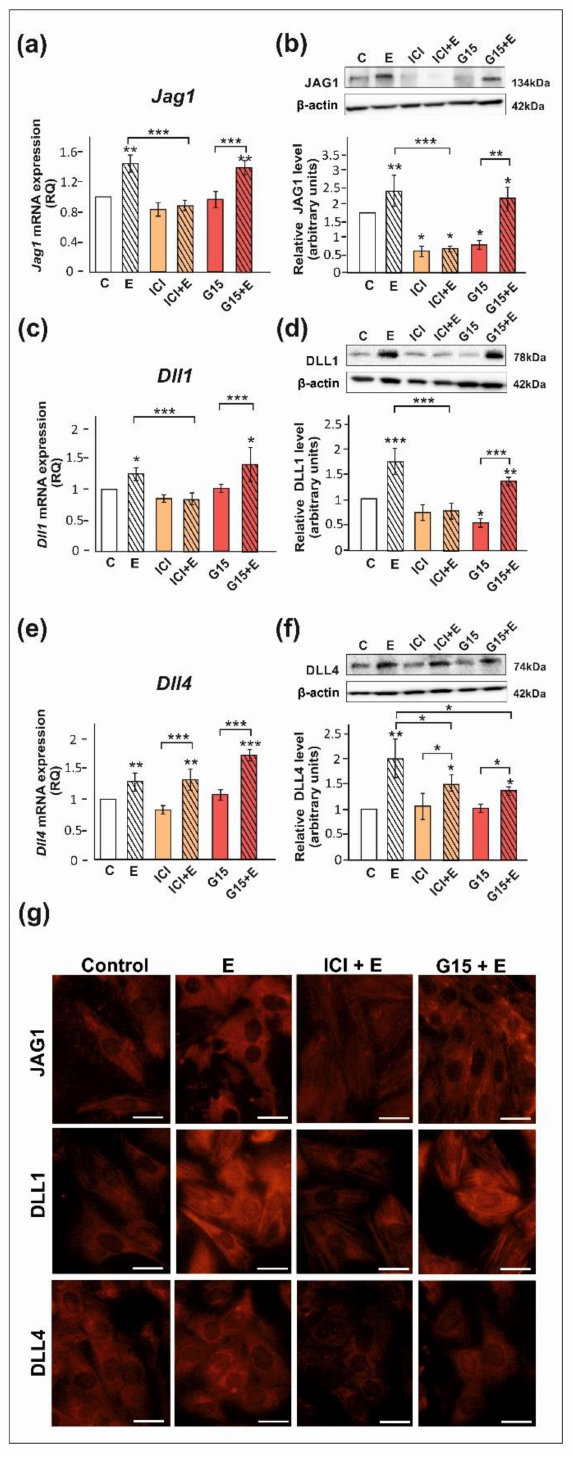
Figure 3. The effect of estrogen receptor antagonists on mRNA and protein expression of Jag1 /JAG1, Dll1 /DLL1, and Dll4 /DLL4 in primary rat Sertoli cells. Cells were treated with 10 − 9 M 17 β -estradiol (E), 10 − 6 M ICI 182,780 (ICI), ICI + E, 10 − 8 M G15, G15 + E, or vehicle (C) for 24 h. ( a , c , e ) Relative expression of mRNAs (RQ) was determined using real-time RT-PCR analysis. The expression values of the individual genes were normalized to the mean expression of the reference genes. ( b , d , f ) Western blot detection of the proteins. The relative level of studied protein was normalized to β -actin. The protein levels within the control group were arbitrarily set at 1. The histograms are